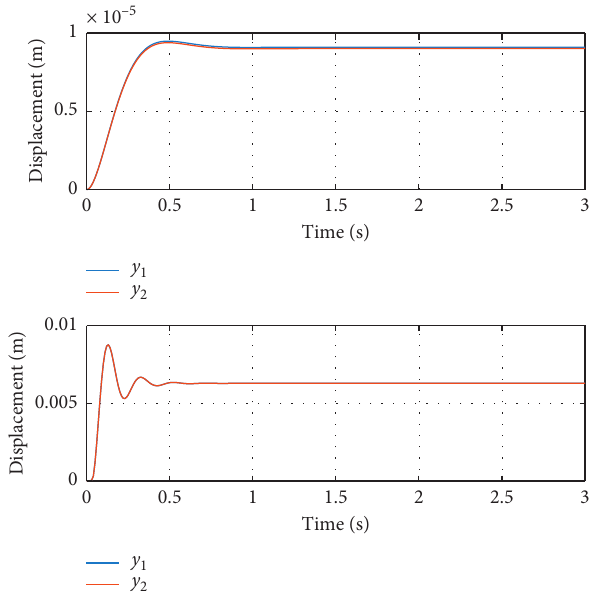
Figure 7: Simulation results under a step signal.